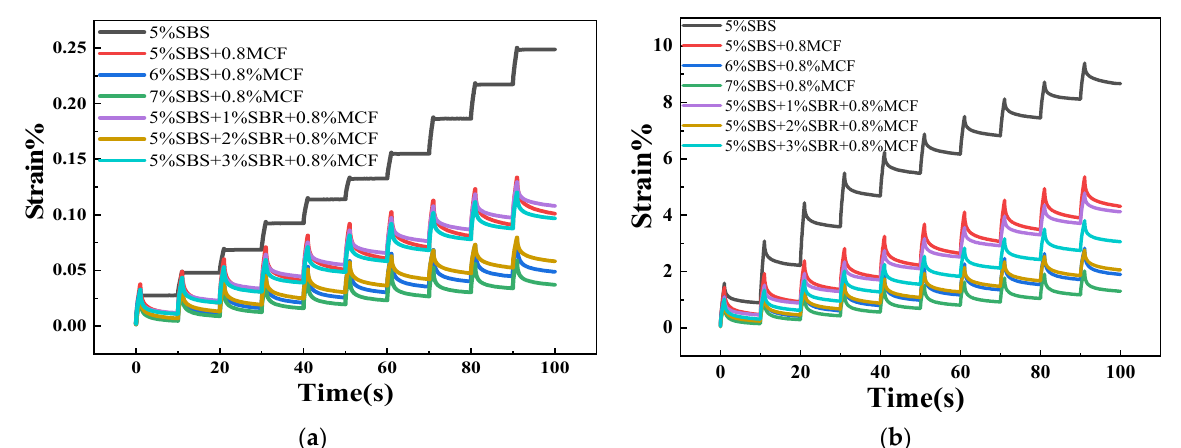
Figure 8. Strain change of asphalt material. ( a ) 0.1 kPa; ( b ) 3.2 kPa. Table 8. MSCR test results of the modified